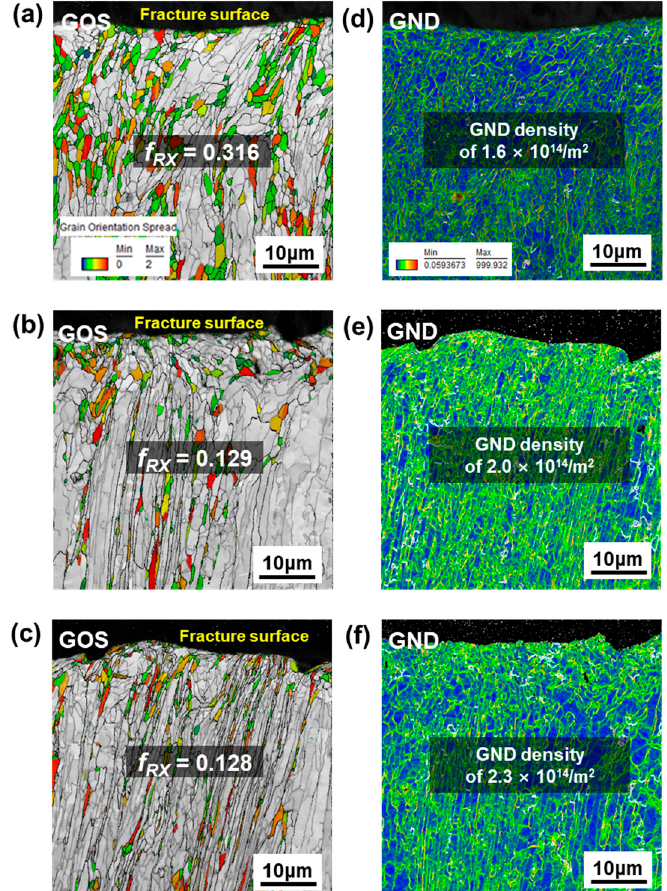
Figure 5. The GOS and GND maps of DF-W sample after tensile tests: ( a , d ) static (1.3 × 10 − 4 s − 1 ), ( b , e ) intermediate-strain-rate (1.1 × 10 − 2 s − 1 ), ( c , f ) high-strain-rate (5.3 × 10 − 1 s − 1 ) conditions.